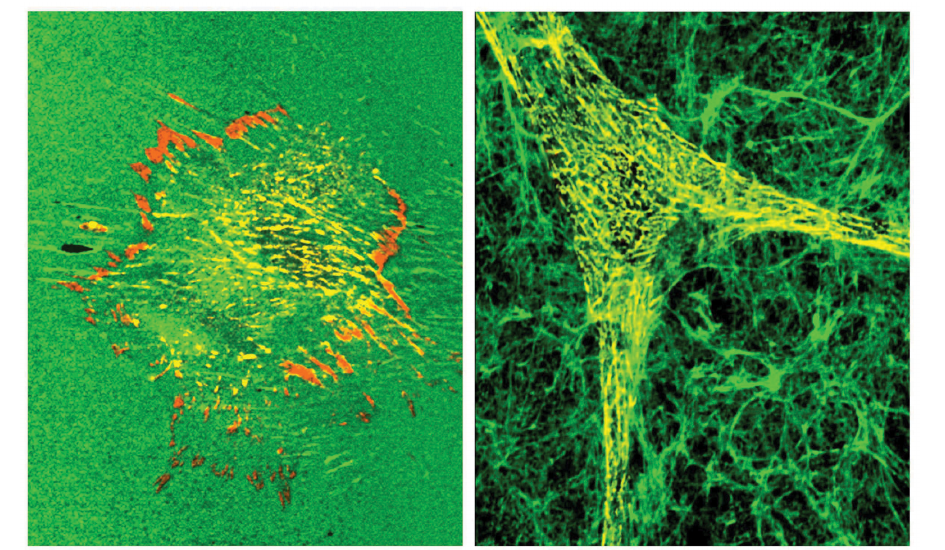
Figure 2. Comparison of fibro- blast cell shapes and localization of components in 2-dimensional and 3-dimensional environ- ments. Cells on 2D substrates tend to spread onto the sub- strate in a flattened morphology (left panel), whereas cells at- taching to 3D matrices rapidly assume an elongated morpholo- gy (right panel) that tends to mimic shapes of fibroblastic and mesenchymal cells in vivo . The α 5 integrin (red) localizes to fo- cal and fibrillar adhesions in cells on 2D substrates coated with fibronectin (green), whereas it is organized into thin, elongated 3D-matrix adhesions in the 3D matrix containing a complex fi- bronectin-containing network of